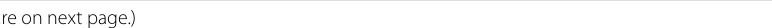
figure on next Fig. 3 Calculated results of seismic moment and seismic interval at the selected regions of seismically dense spheres 1–8. The relationship between the logarithm of the seismic moment (red curve, left vertical axis, log[Nm]) and the logarithm of the seismic interval (blue curve, right vertical axis, log[s]) during the period from October 1, 1997 to February 28, 2015. The pink circles in the upper part are the contemporaneous Mw > 5 earthquakes outside of the seismically dense spheres, which may potentially influence the seismicity inside. The upper right box indicates the relationship between the seismic moment and the seismic interval in the Mo–SI diagram. Orange points indicate the events immediately after a day-based maximum seismic interval (DMSI). Red points indicate the events immediately after a month-based maximum seismic interval (MMSI). The cyan line indicates the predicted Mo–SI distribution following Eq. 3, while the gray line indicates the predicted Mo–SI distribution following Eq.